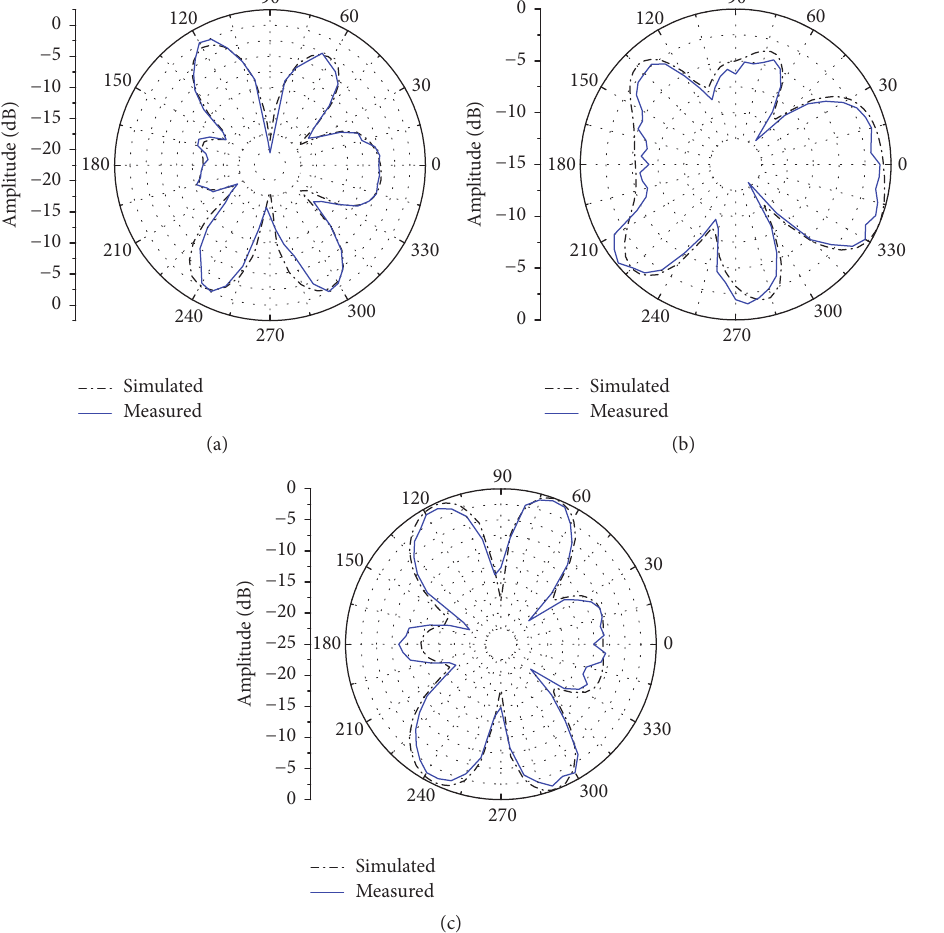
Figure 11: Simulated and measured radiation pattern for different values of 𝑡 02 at 5.8 GHz. (a) 𝑡 02 = 0 𝜇 sec. (b) 𝑡 02 = 0.125 𝜇 sec. (c) 𝑡 02 = 0.375 𝜇